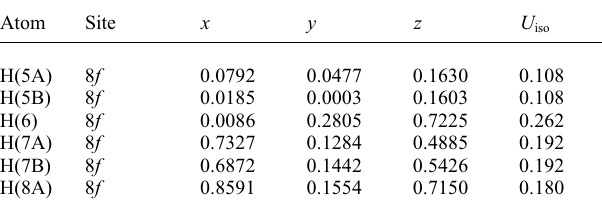
Table 3. Atomic coordinates and displacement parameters (in Å 2 )